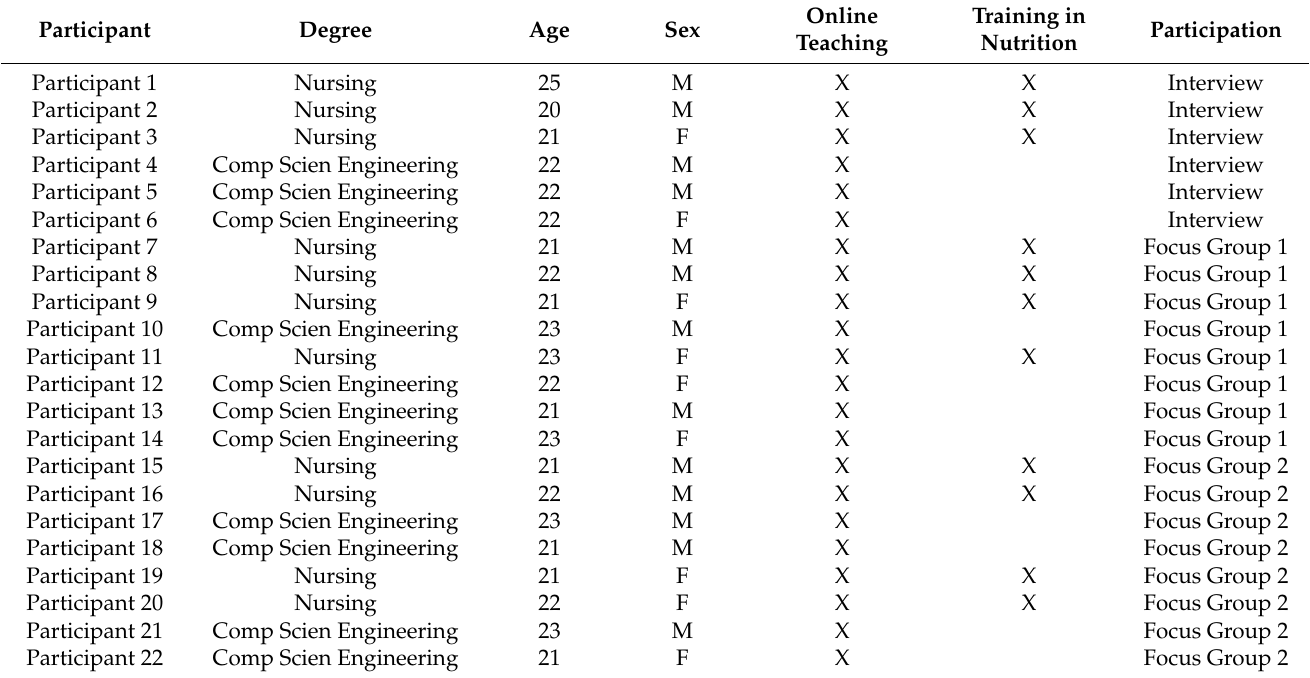
Table 1. Sociodemographic characteristics of